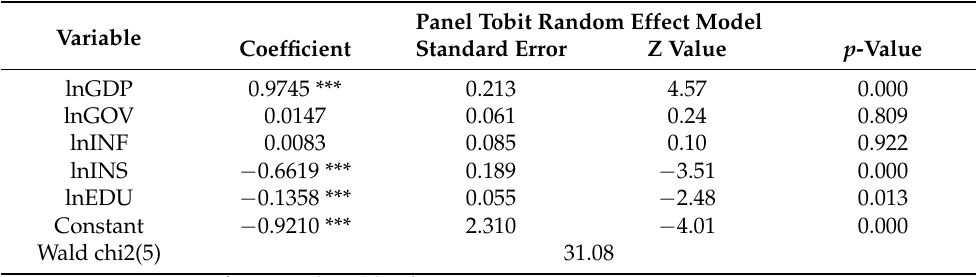
Table 5. Regression results of influencing factors of green innovation in the Great Changsha-Zhuzhou- Xiangtan City Group based on